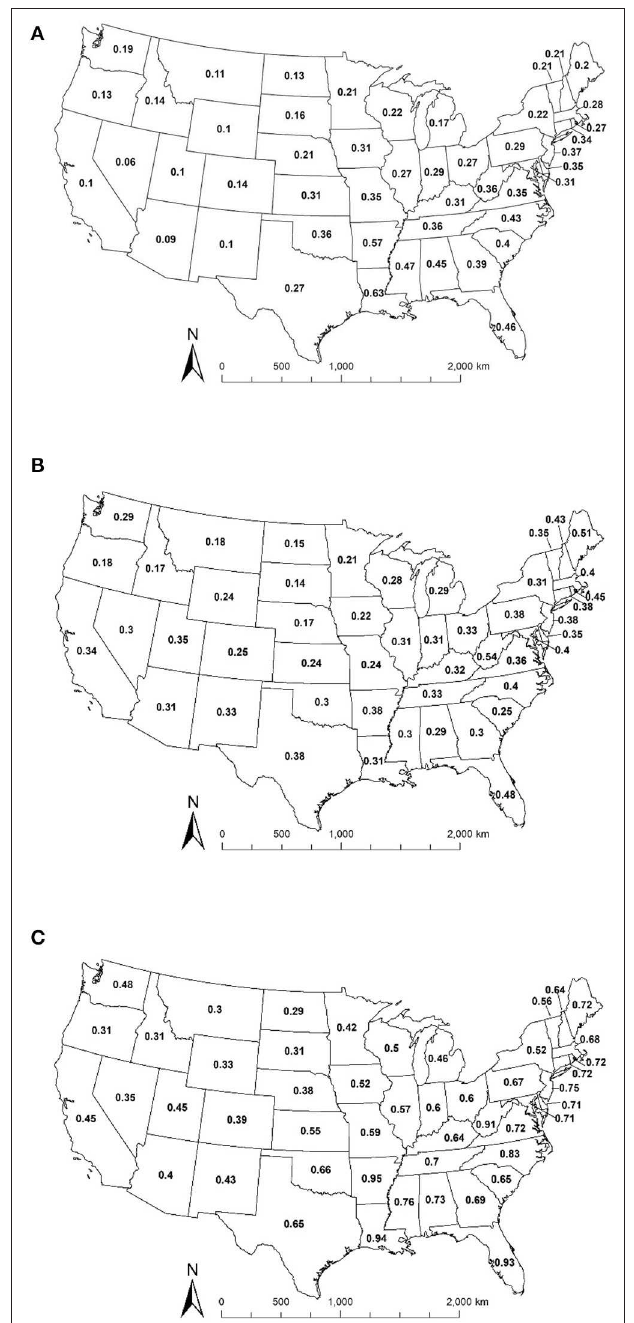
FIGURE 3 | Area-normalized value of annual K + deposition ($/ha) for different states in the contiguous United States based on a moving 5-year average price of U.S. $500 per metric ton of potassium chloride (KCl) (Yager, 2016): (A) wet, (B) dry, and (C) total.